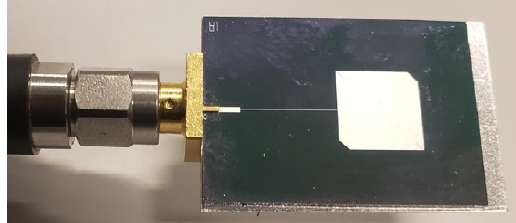
Figure 13. A photograph of the second antenna.